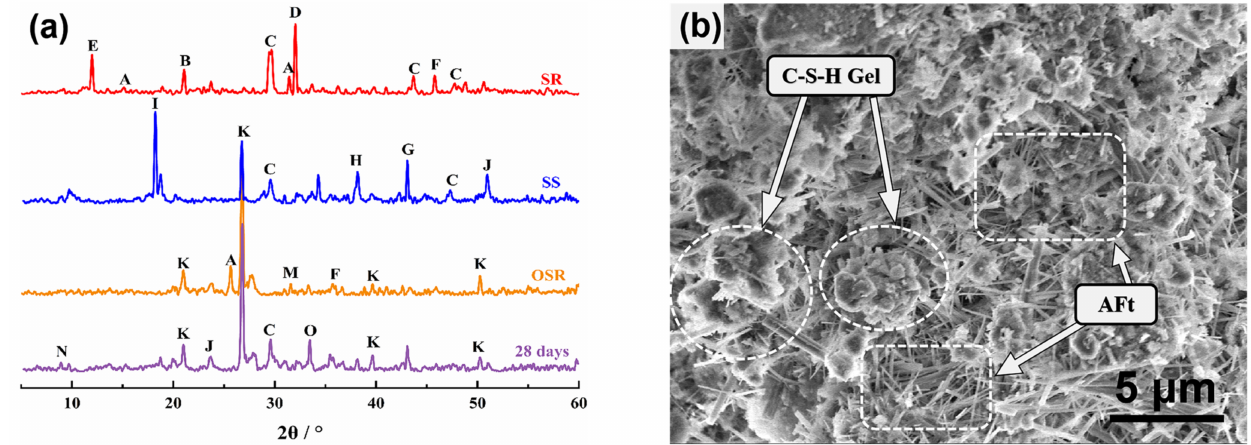
Figure 3. Microscopic testing of specimens: ( a ) XRD of raw material compared to SWCPB; ( b ) SEM of SWCPB. (In ( a ): A: CaSO 4 ; B: CaSO 4 · 2H 2 O; C: cancrinite; D: Na 2 SO 4 ; E: magnesian calcite; F: NaCl;